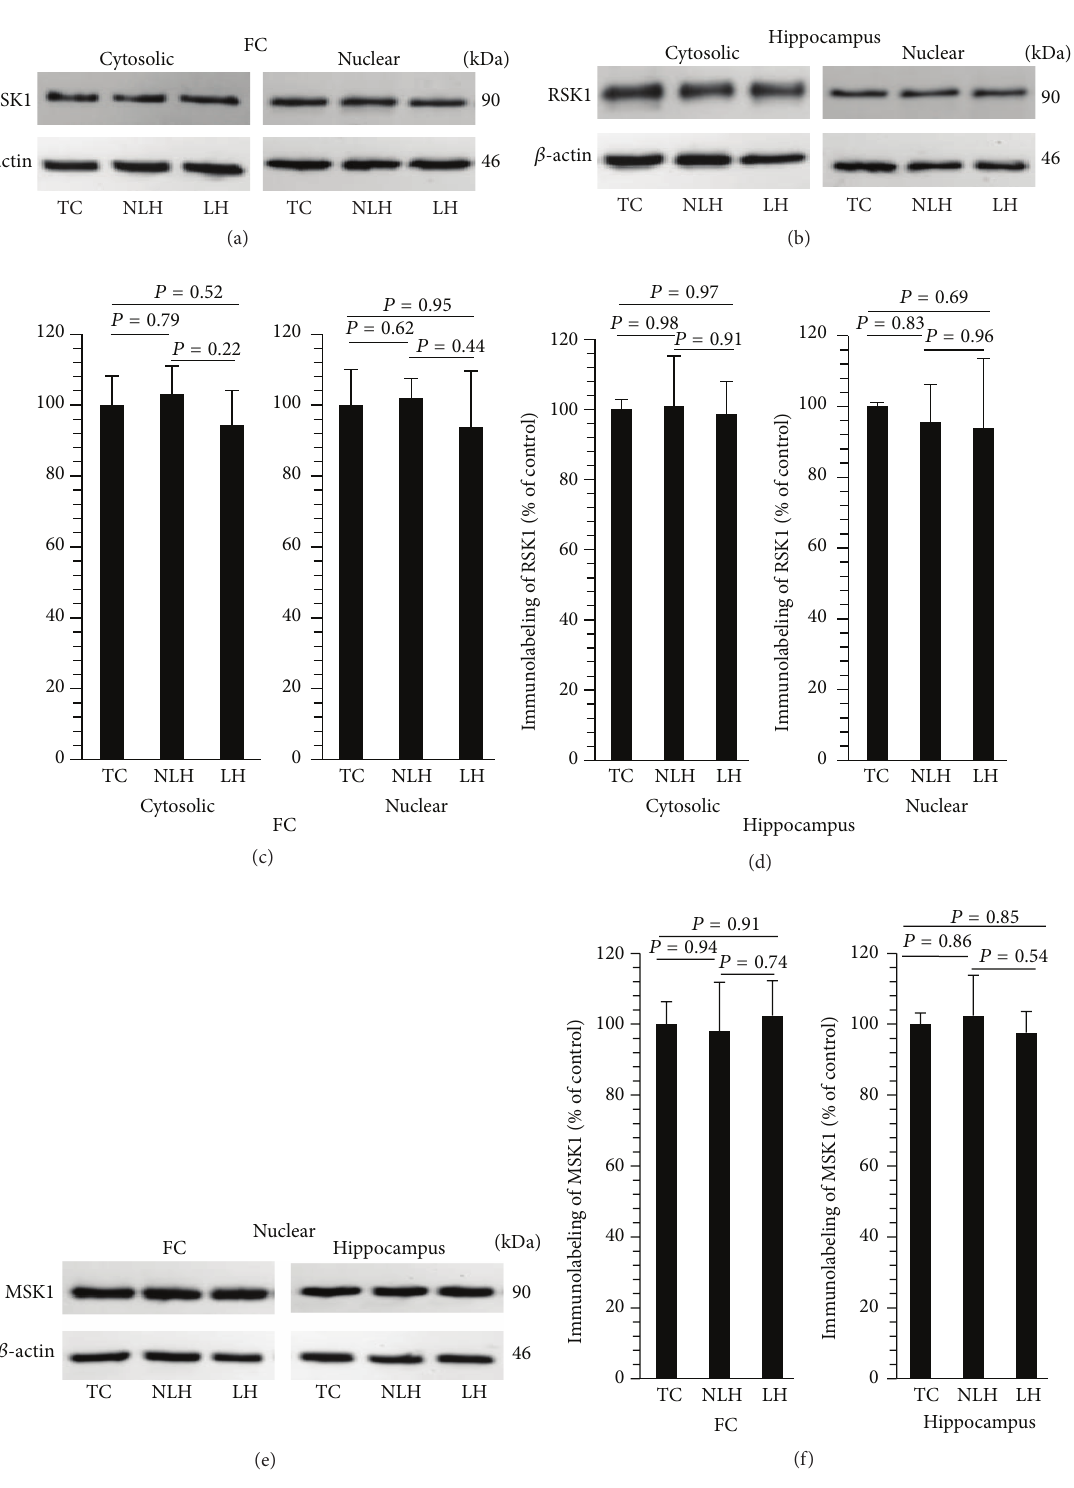
Figure 10: Representative immunoblots of total RSK1 in cytosolic and nuclear fractions of frontal cortex (FC) (a) and hippocampus (b) and MSK1 in nuclear fractions of FC and hippocampus (d) obtained from tested control (TC), non-learned helpless (non-LH), and learned helpless (LH) rats. 𝛽 -actin was used as endogenous control. Differences in expression of RSK1 and MSK1 in FC and hippocampus between TC, non-LH, and LH rats are shown in (c) and (e), respectively. Data are the mean ± SD from 6 rats in each group. Overall group differences for RSK1 among TC, non-LH, and LH rats are as follows. FC, cytosolic: df = 2, 15 , 𝐹 = 1.58 , and 𝑃 = 0.23 ; nuclear: df = 2,15 , 𝐹 = 0.85 , and 𝑃 = 0.44 . Hippocampus, cytosolic: df = 2, 15 , 𝐹 = 0.08 , and 𝑃 = 0.92 ; nuclear: df = 2, 15 , 𝐹 = 0.36 , and 𝑃 = 0.70 . Overall group differences for MSK1 in nuclear fraction among TC, non-LH, and LH rats are as follows. FC: df = 2, 15 , 𝐹 = 0.27 , and 𝑃 = 0.76 ; hippocampus: df = 2,15 , 𝐹 = 0.58 , and 𝑃 = 0.57 . No significant differences were found in expression of RSK1 or MSK1 in any brain